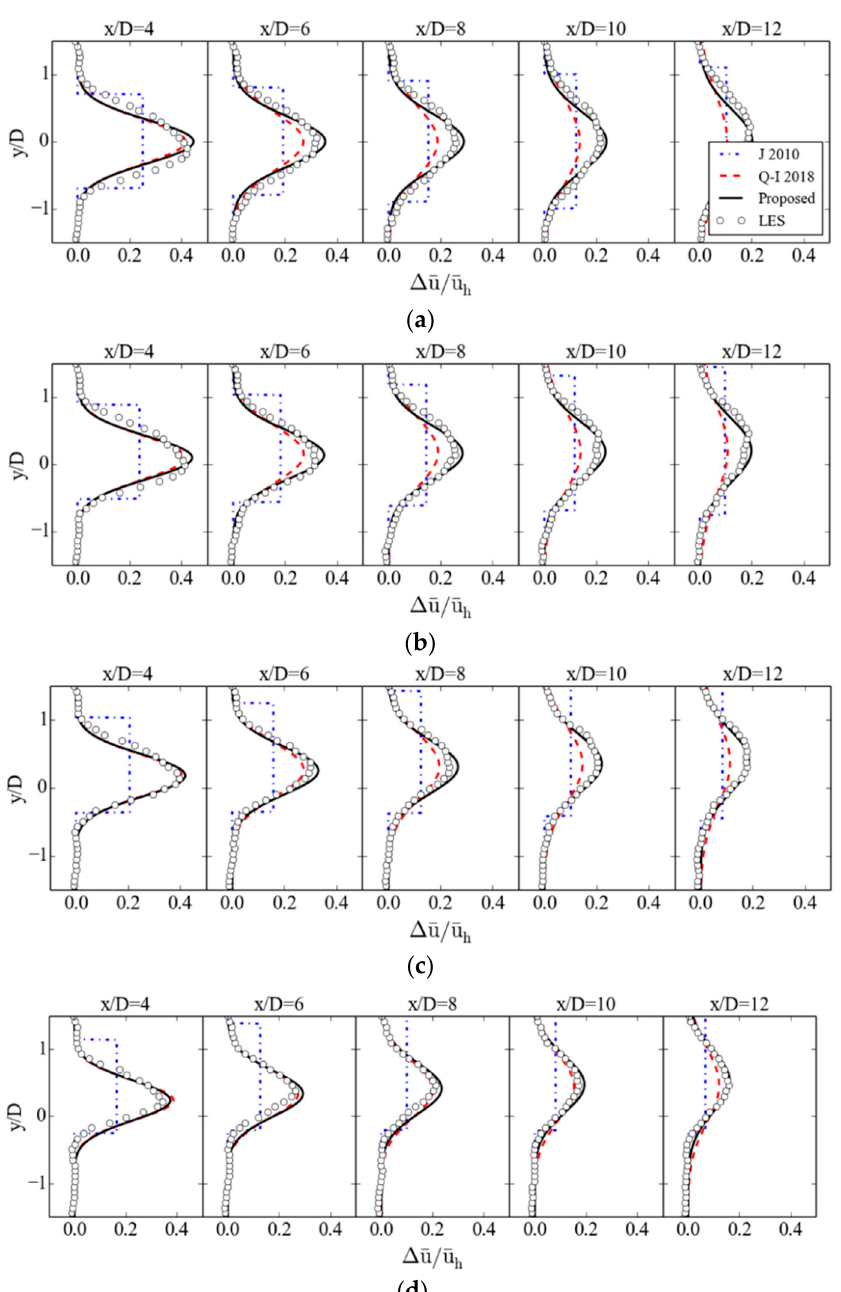
Figure 10. Contour plots of normalized mean streamwise velocity in the horizontal plane at hub height for different yaw angles: ( a ) γ = 0°; ( b ) γ = 10°; ( c ) γ = 20°; ( d ) γ = 30°. The black solid lines denote the wind turbine rotors.